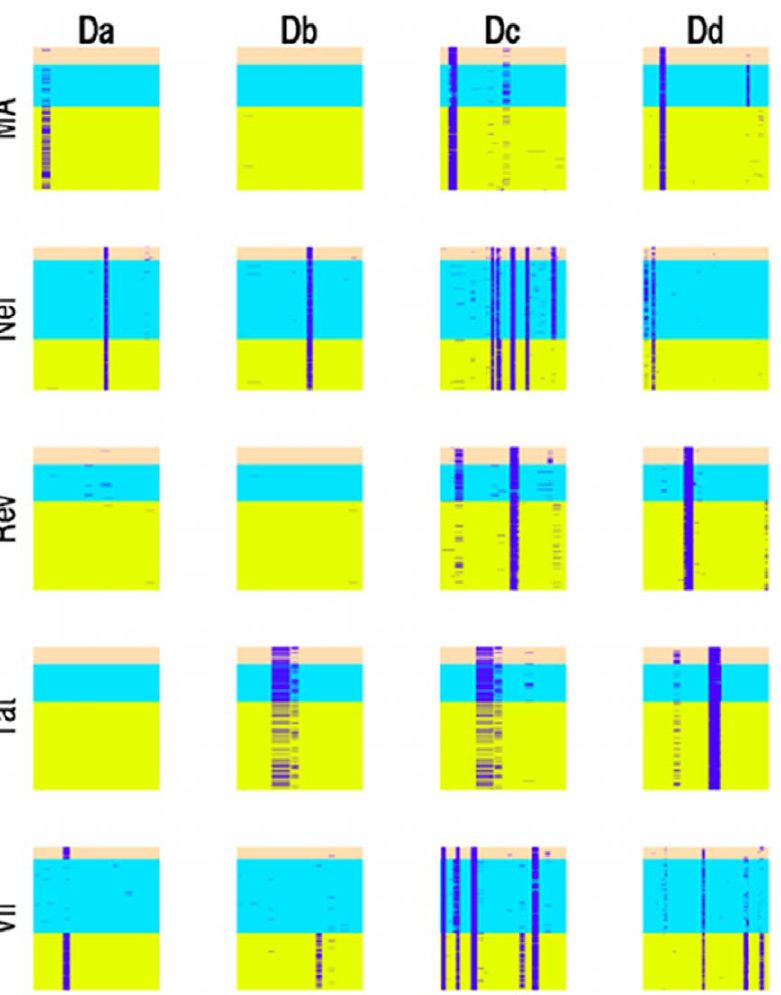
Figure 1. D-site pattern hits on HIV proteins. Hits for the standard MAPK docking sites, Da and Db , and the proposed MAPK docking sites patterns, Dc and Dd , are annotated in purple on multiple sequence alignments of HIV proteins MA, Nef, Rev, Tat, and Vif. Subtypes in each alignment are represented by different colors: A1 is pink, B is blue, and C is green. Note that motif annotations occur in roughly the same position within a virus subtype.